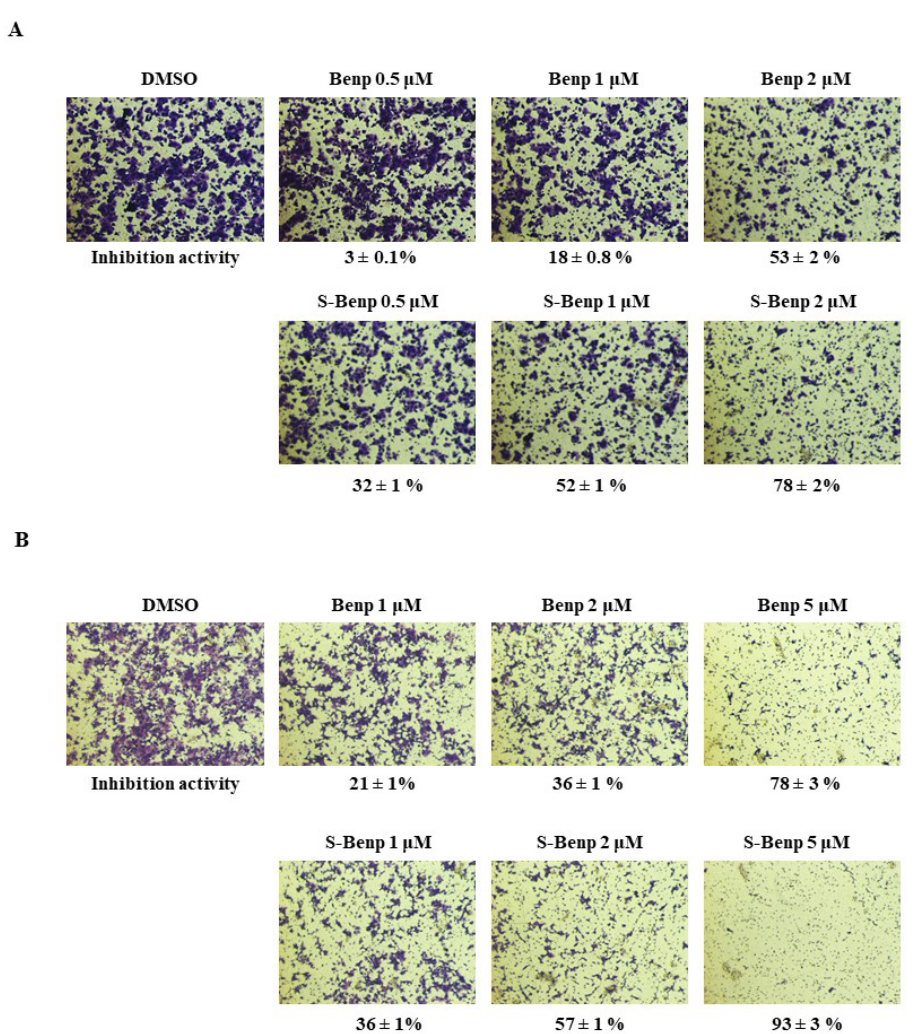
Figure 2. Benp and S-Benp inhibited cancer cell migration and invasion in a dose-dependent manner in DLD-1 cells. ( A ) Migration assay in Benp- or S-Benp-treated DLD-1 cells. Migrated cells were examined via a Transwell migration system and stained with crystal violet. ( B ) Cell invasion assay of Benp and S-Benp at 1, 2, and 5 µM in DLD-1 cells. Using Matrigel-coated Transwell inserts, the invasive cells were observed and analyzed. The data represent means ± s.d.; comparisons were performed with t tests (two groups).